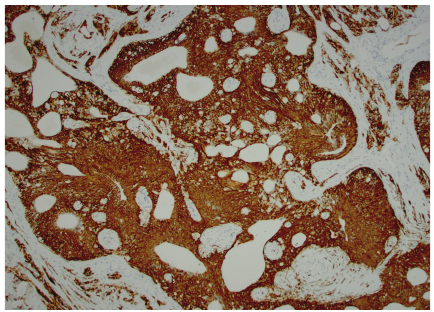
Figure 4: The ependymoma component stained positive for GFAP.